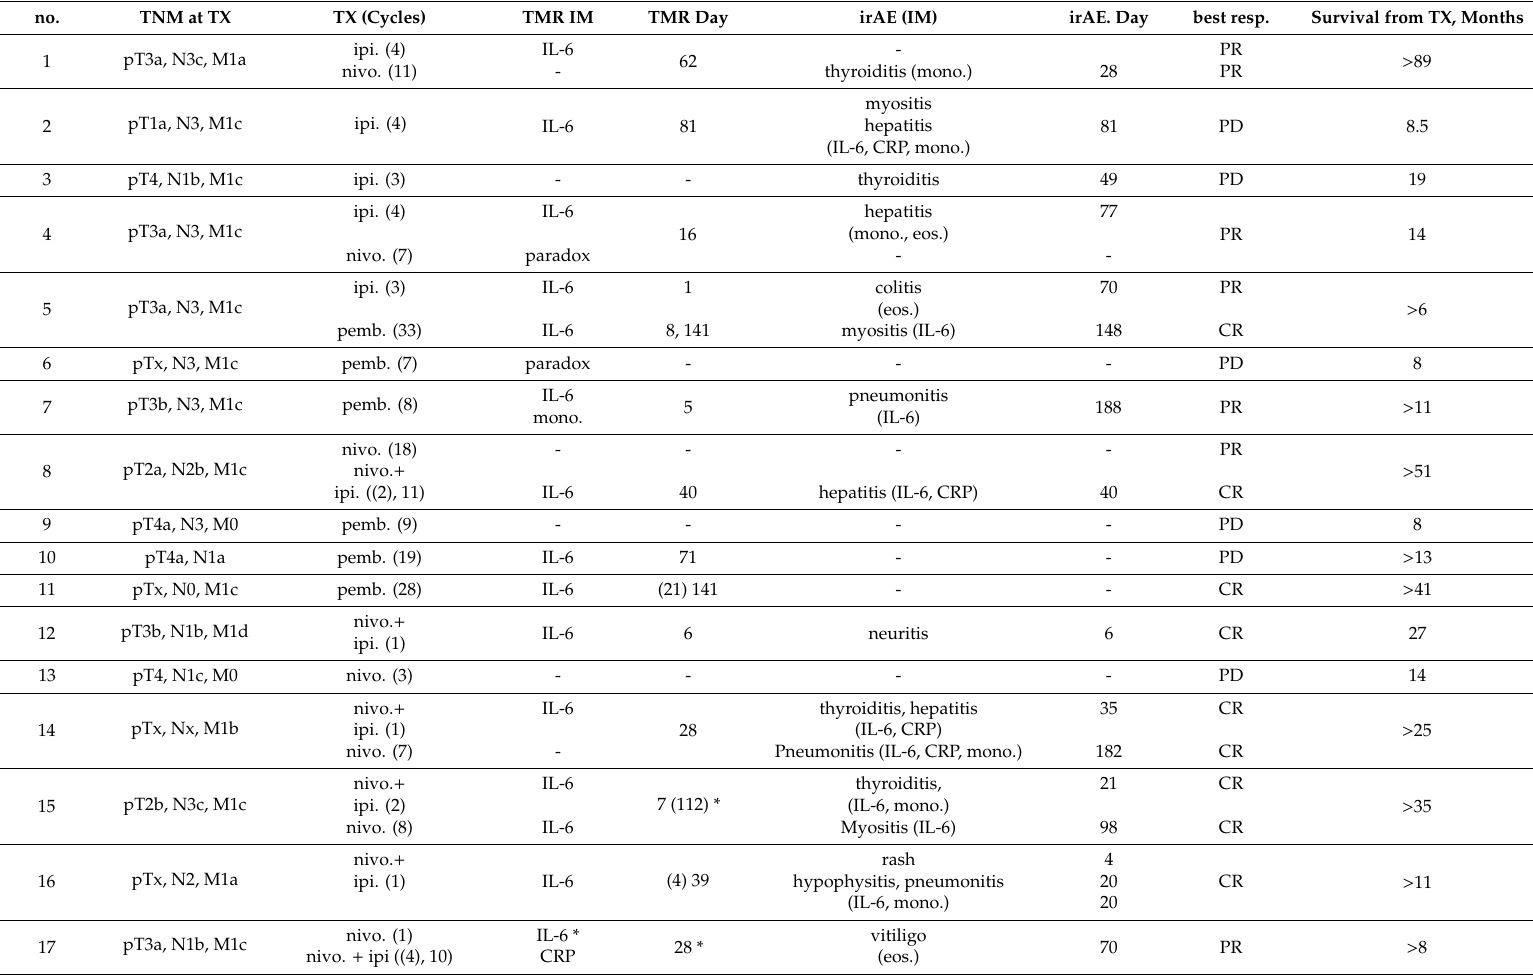
Table 4. Tumor marker release, immunologic adverse e ff ects and response to therapy in 14 patients treated with immune checkpoint